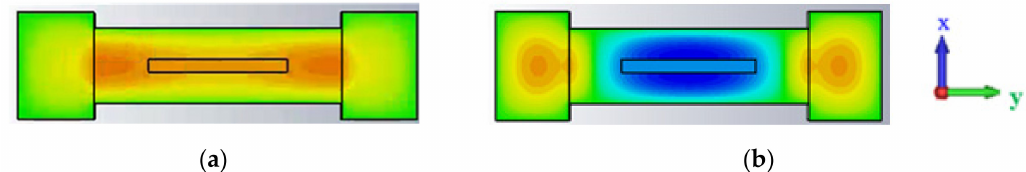
Figure 2. Electric field distribution of ( a ) fundamental TM 11 mode and ( b ) high-order TM 31